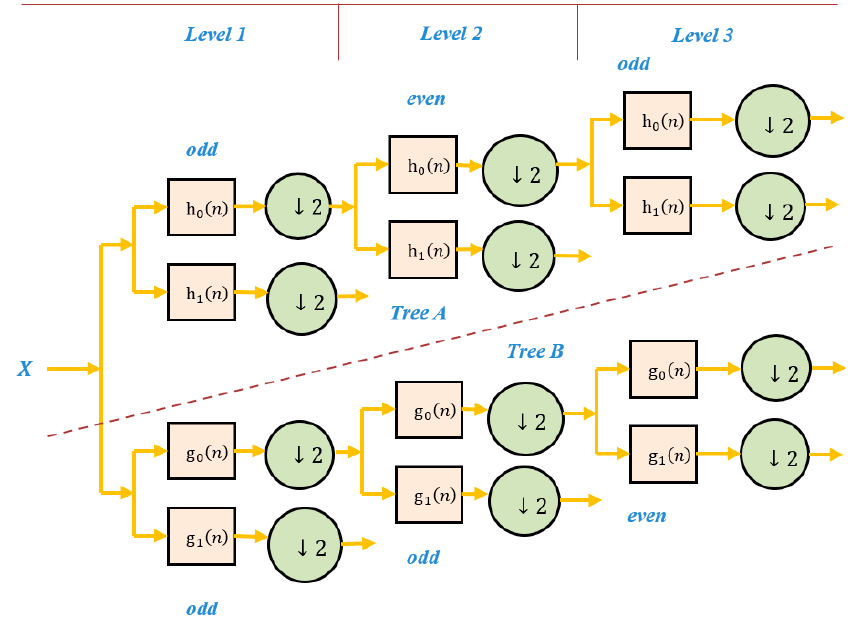
Figure 2. DTCWT bank filter’s